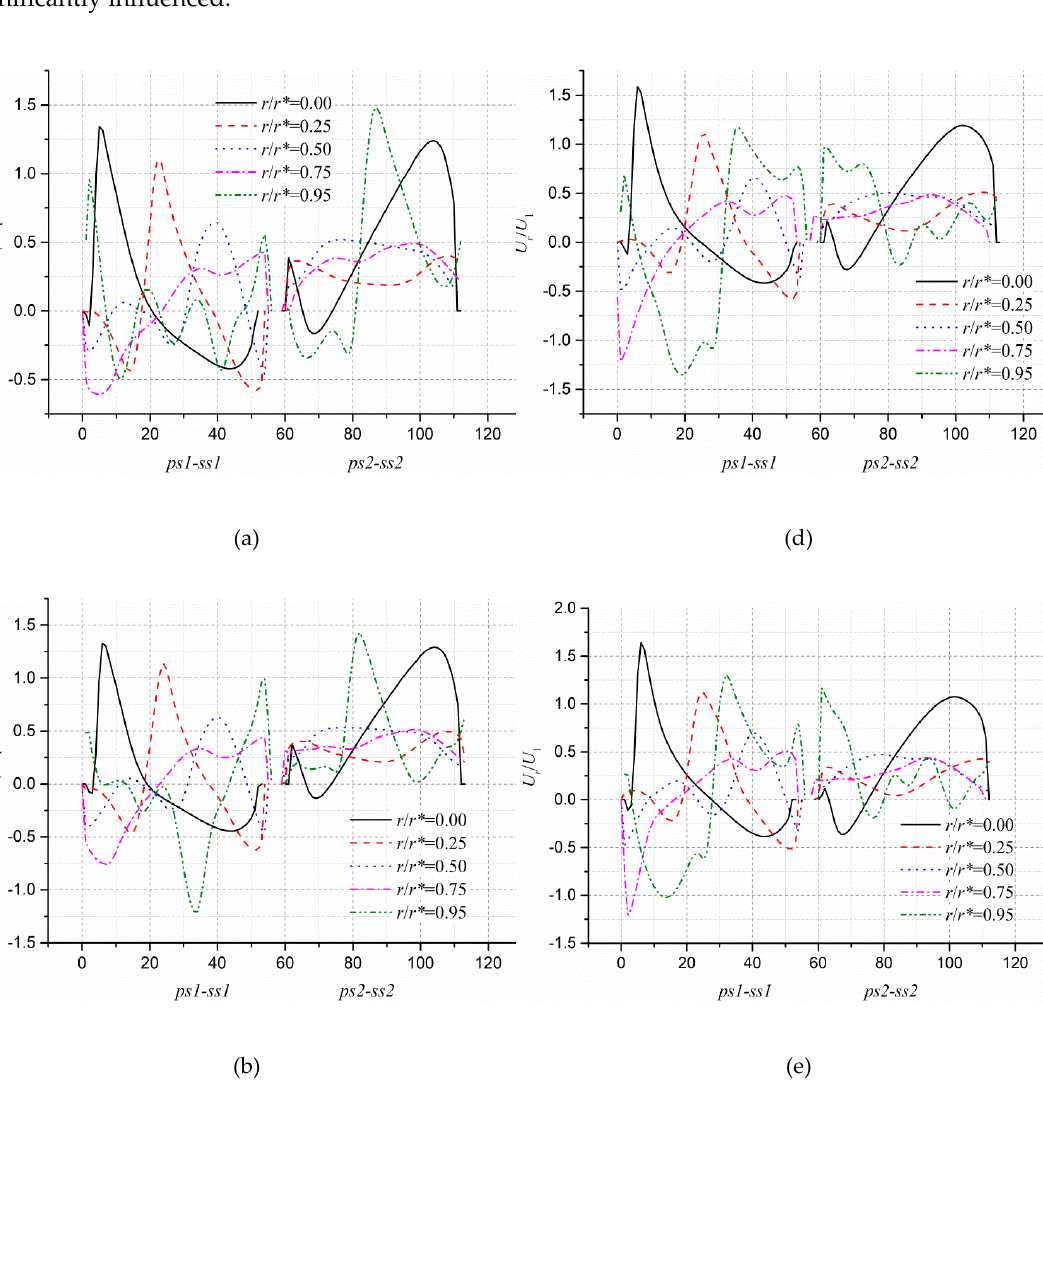
(f) Figure 15. Blade-to-blade distribution of instantaneous radial velocity for the Z / b 2 = 0.5 cross section: ( a ) t = 1/12 T , ( b ) t = 3/12 T , ( c ) t = 5/12 T , ( d ) t = 7/12 T , ( e ) t = 9/12 T , and ( f ) t = 11/12 T . 4.